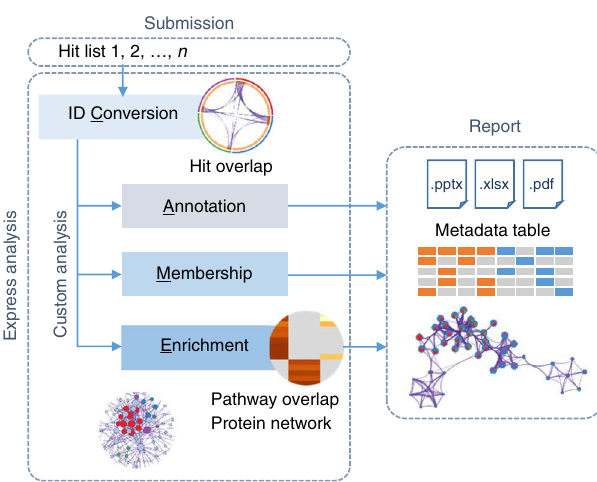
Fig. 1 Schematic outline of the Metascape analysis work fl ow. Upon gene list submission, Custom Analysis enables users to navigate the analysis work fl ow and output a report. The Express Analysis instead takes a streamlined approach by running the analysis steps with popular default settings, simplifying the user